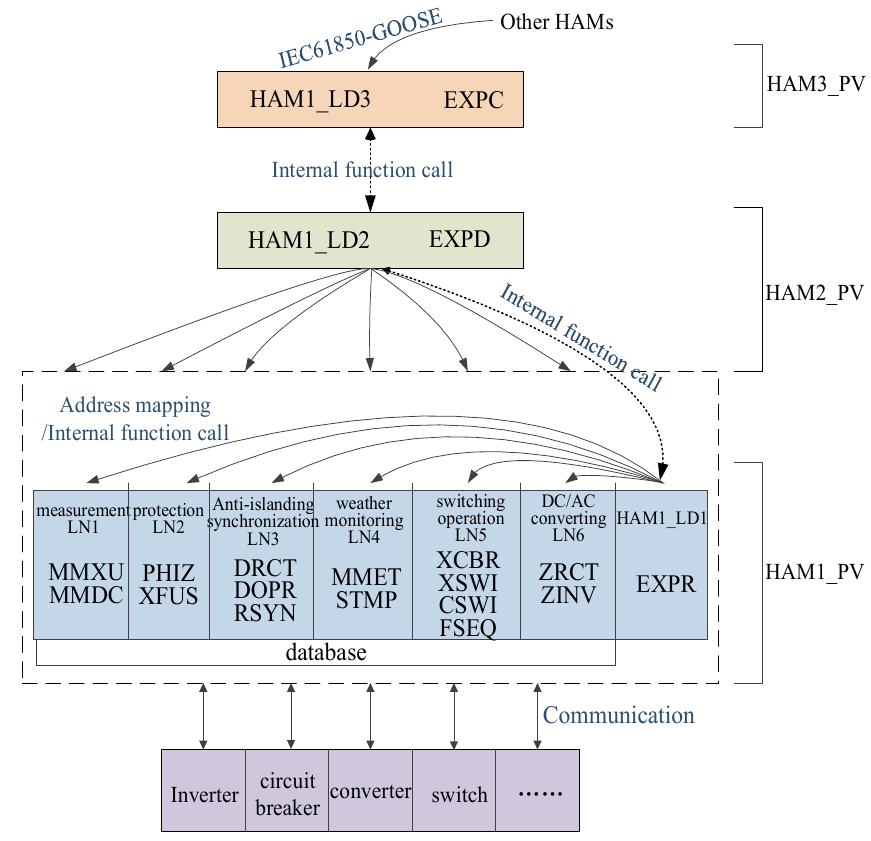
Figure 5. IEC 61850 data model of photovoltaic